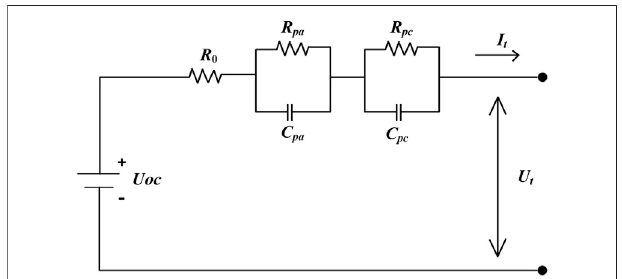
FIGURE 1 | The second-order RC